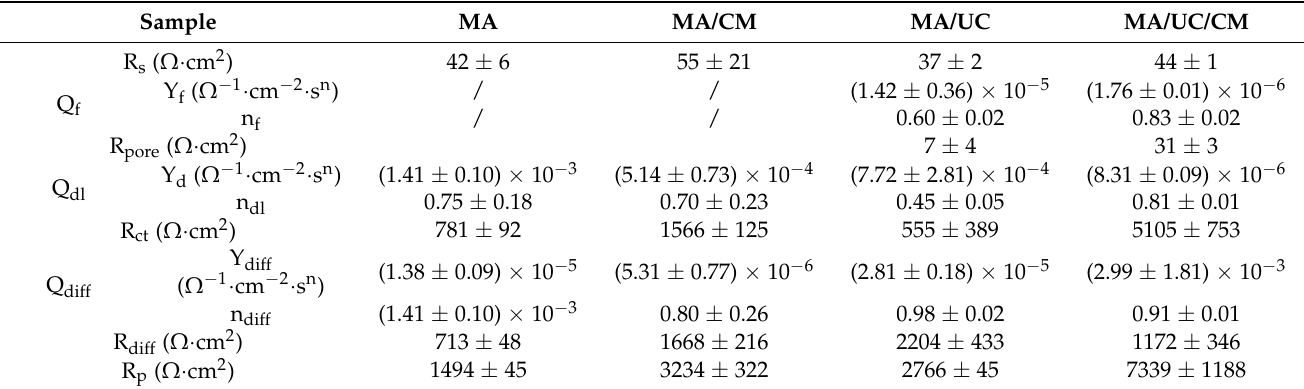
Table 1. Fitted EIS data based on the equivalent circuits.